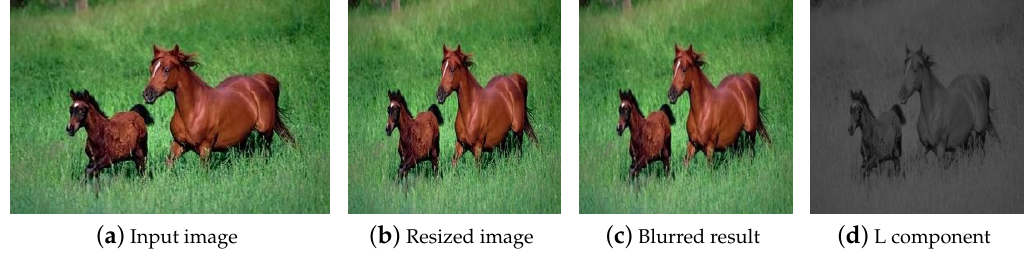
Figure 3. An example of